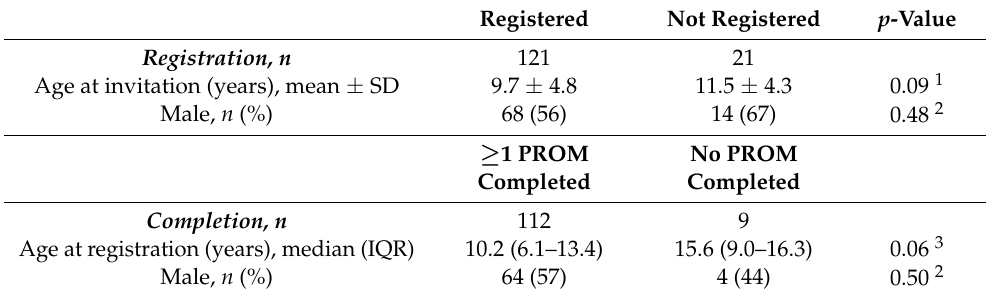
Figure 3. Bar plot of the proportion (%) of impaired ( A ) TAPQOL subscale scores ( n = 22) and ( B ) total PedsQL score and subscale scores for proxy-report (5–7 years, n = 10) and self-report (8–18 years, n = 54) in CKD patients. Impaired HRQoL is defined as a score below 1 SD of the mean score of the reference group. By definition, the prevalence of impaired HRQoL in the reference group is 16% for each domain (represented by the horizontal dashed line). Table 1. Demographics of subjects who were invited to use the KLIK PROM portal. Demographics were compared between CKD patients who registered at the KLIK PROM portal and who did not, and of those, who completed at least one PROM and who did not. CKD = chronic kidney disease; IQR = interquartile range; and SD = standard